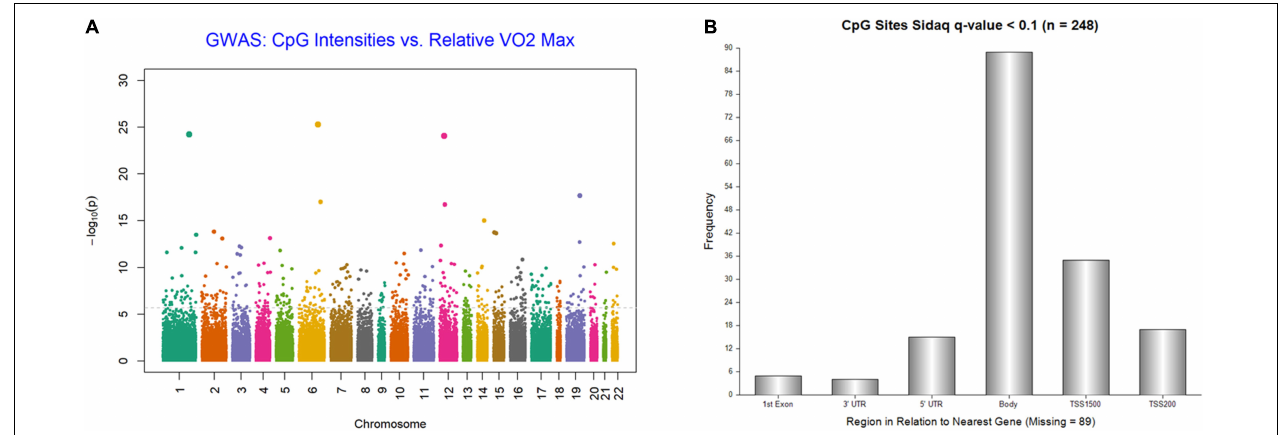
FIGURE 1 | (A) Genome-wide plot for DNA methylation analysis of CpG intensities and relative VO 2 Max; distribution is based on location and chromosomal position for all 478,570 probes in Infinium HumanMethylation450 BeadChip assay. (B) Frequency of 248 CpG Islands by region to nearest Gene (sidakq < 0.1) that exhibited differential DNA methylation after 6-month aerobic exercise-training; 89 located in the Body; 35 in TSS1500; 17 in TSS200; 15 in 5 (cid:48) UTR; 5 in 1st Exon; and 4 in the 3 (cid:48) UTR regions to the nearest gene.